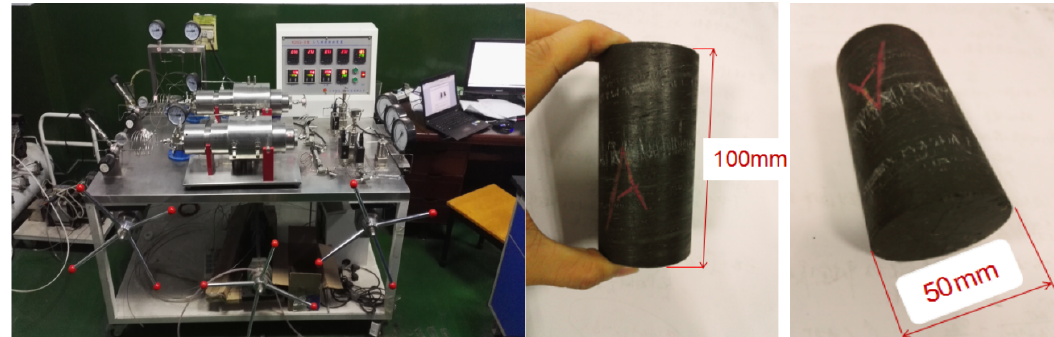
Figure 2 - The experimental apparatus and test